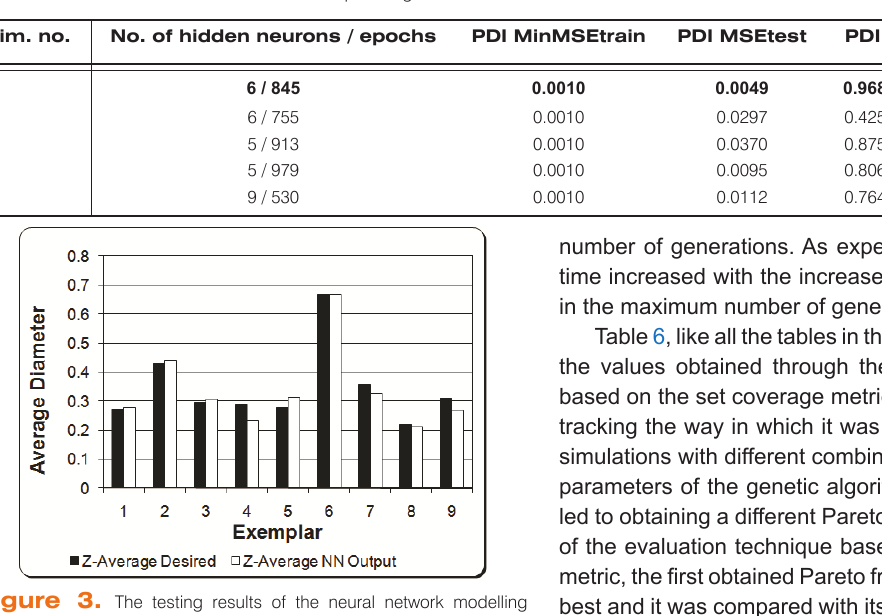
Figure 3. The testing results of the neural network modelling the average diameter for unseen data.